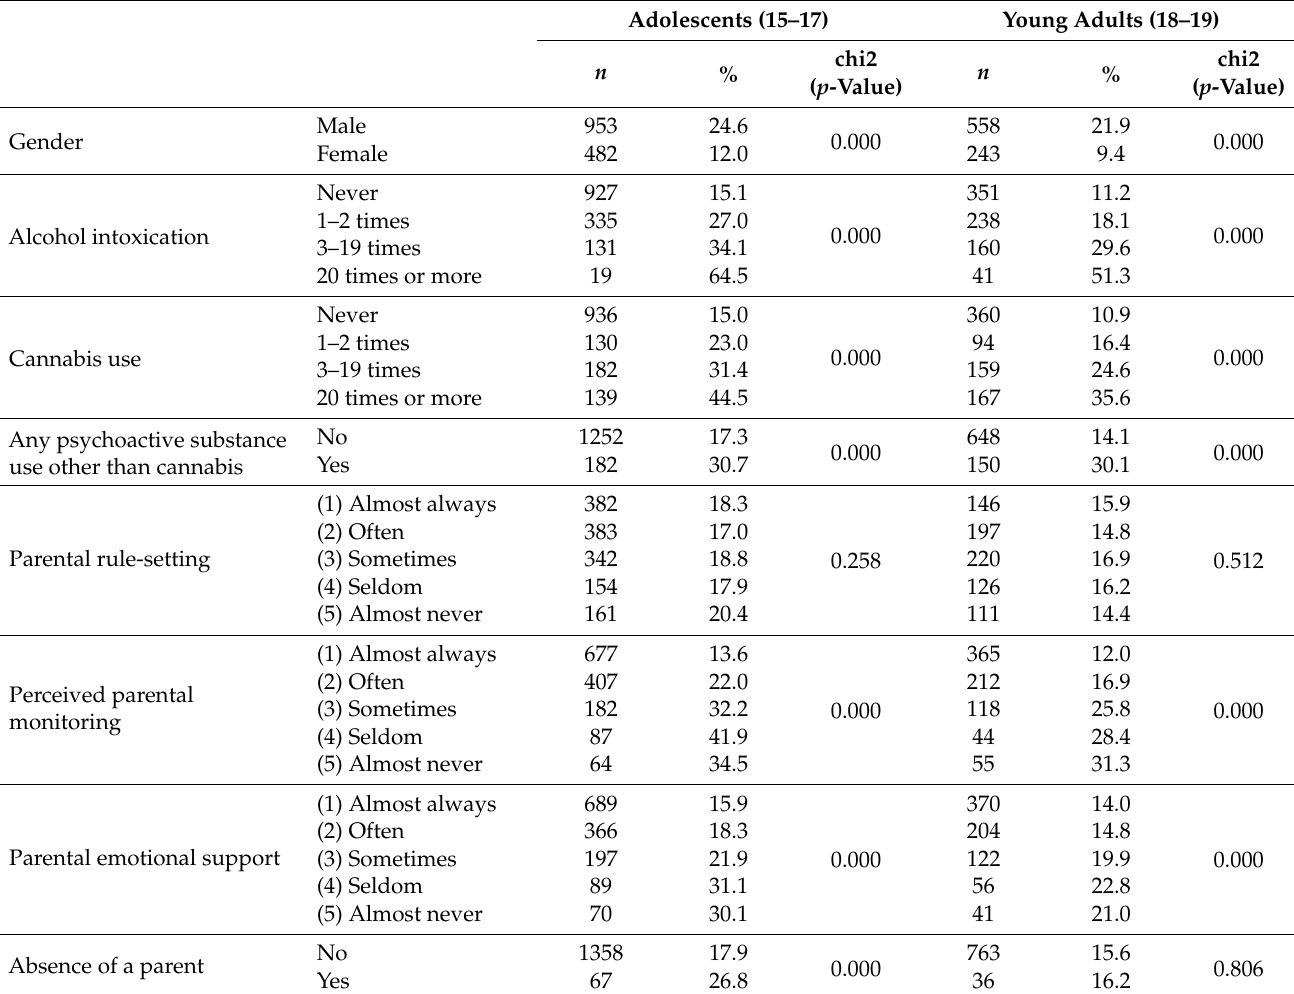
Table 2. Differences in prevalence of violent behaviour by demographic data and other independent